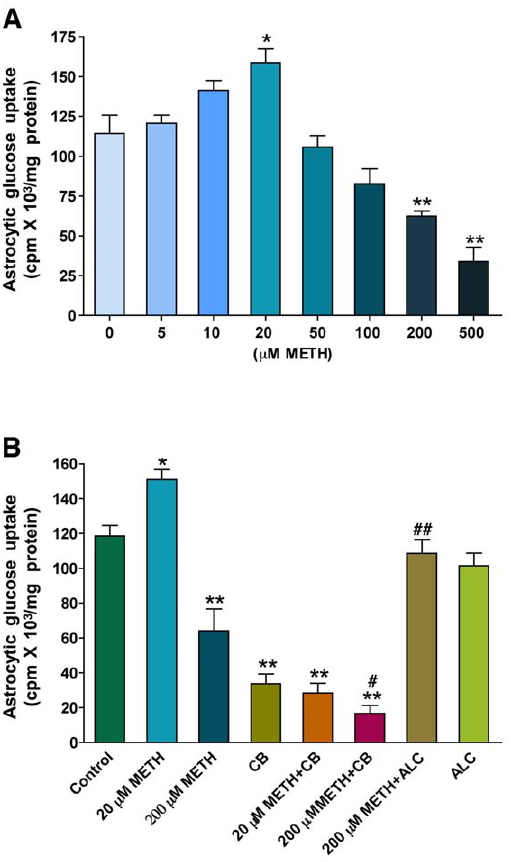
Figure 6. Dual effects of METH on glucose uptake in astrocytes: A. Dose dependent effects of METH on D-(2- 3 H)-glucose uptake by human astrocytes for 24 hr. B. Effects of GLUT inhibitor cytochalasin B (10 m M) and ALC (100 m M) on glucose uptake by astrocytes following 20 m M and 200 m M of METH for 24 hr treatment. Statistically significant (n=5), *p , 0.05, **p , 0.01 compared with controls in A and B and # P , 0.05, ## p , 0.01 with 200 m M METH in B (third bar).